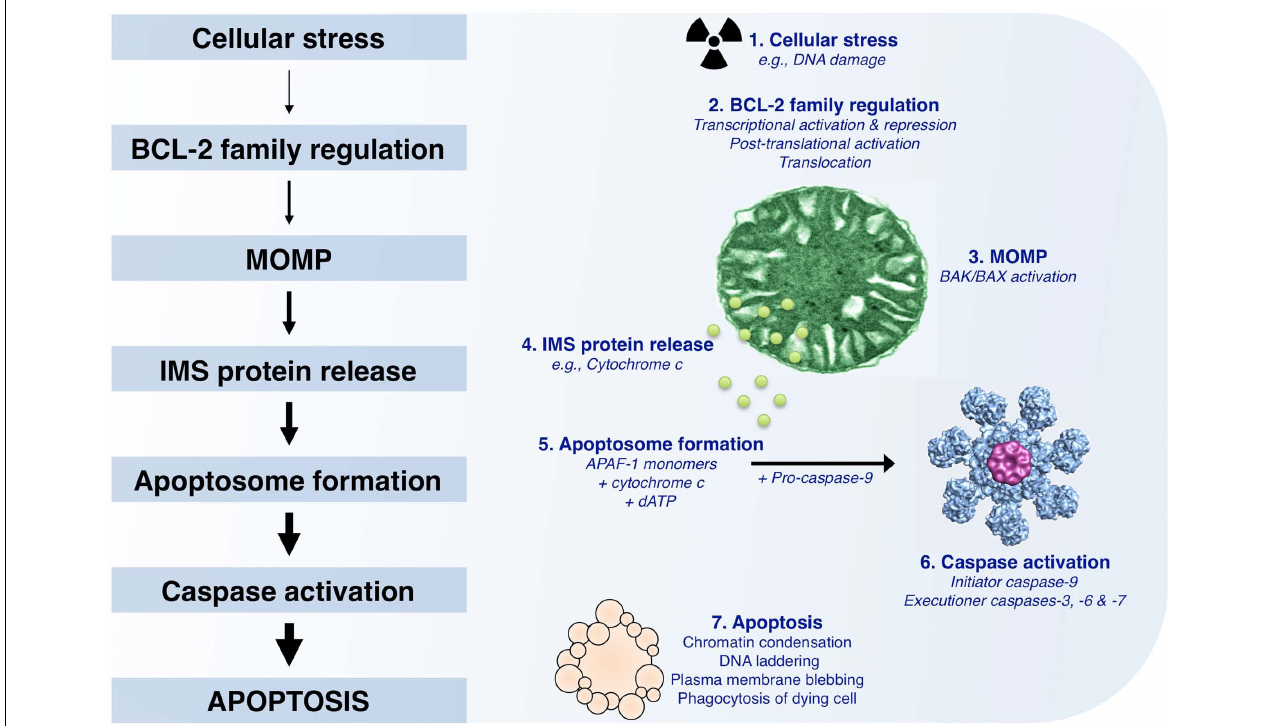
oligomerization and recruitment of pro-caspase-9; this complex is referred to as the “apoptosome.”The apoptosome allows for pro-caspase-9 dimerization and activation, and the subsequent cleavage and activation of executioner caspases (caspase-3, -6, and -7).These caspases promote the characteristic phenotypes of apoptosis, e.g., chromatin condensation, DNA laddering, and plasma membrane blebbing, by cleaving numerous intracellular substrates. Within the body, apoptotic cells are rapidly cleared by phagocytosis to ensure tissue homeostasis.